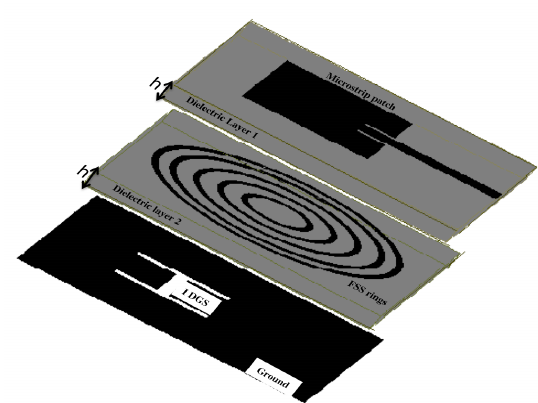
Figure 1: Proposed Composite Antenna The optimized antenna is proposed and designed based on the following configurations that are taken into consderations shown in figure 1(a-c).